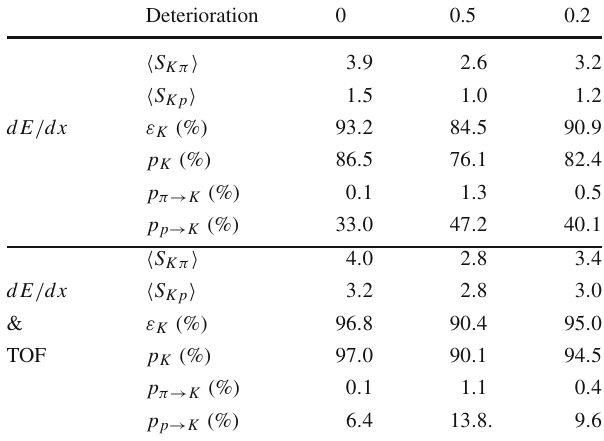
Table 2 Expected PID performance parameters at the CEPC in differ- ent scenarios. Shown are the average value of particles with momenta from 2–20 GeV/c in the e + e − → Z → q ¯ q